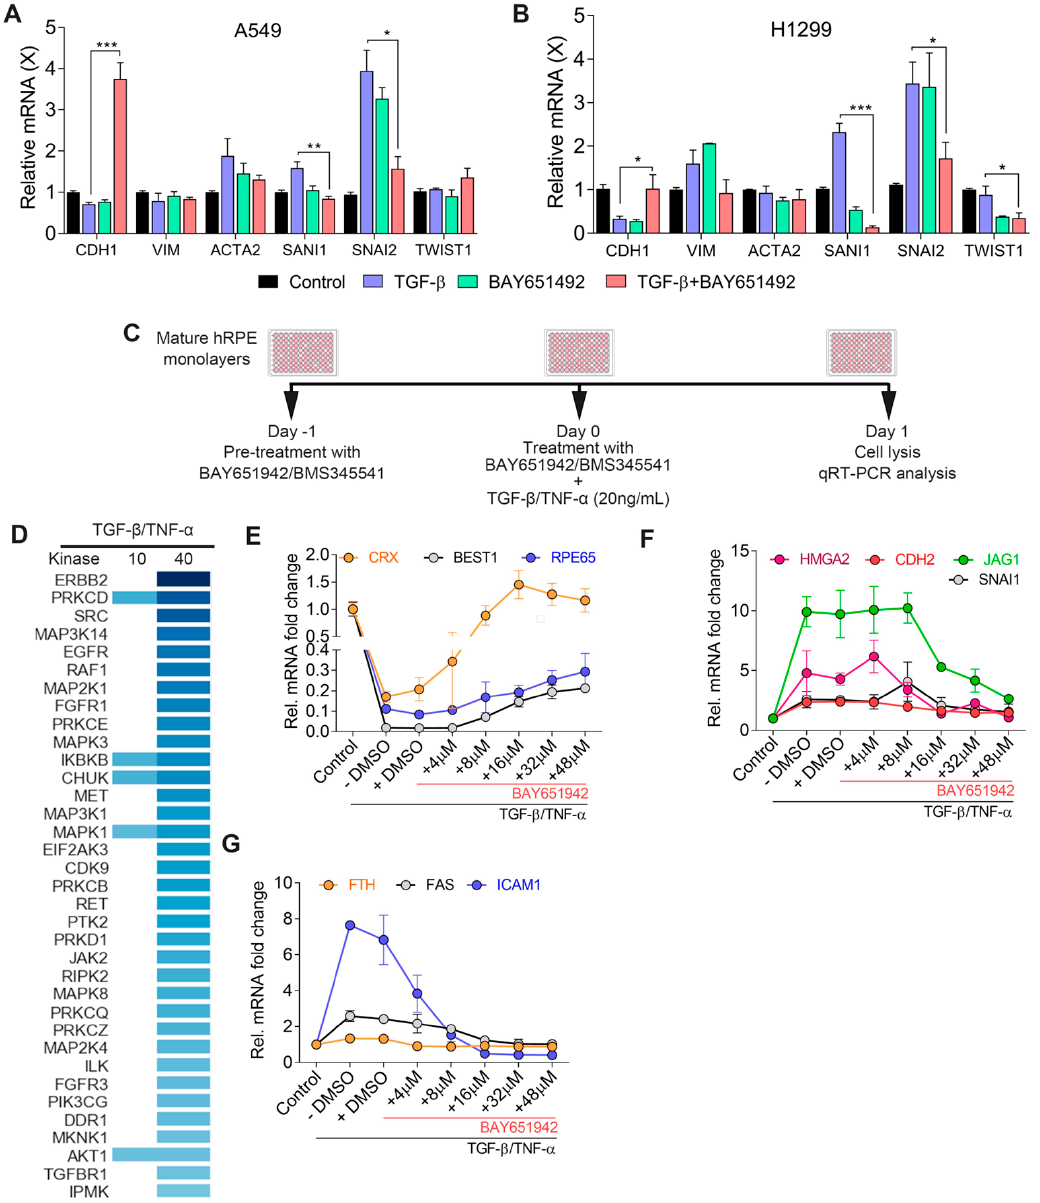
Figure 1. Identification of small molecule kinase inhibitors that modulate TGF– β /TNF– α associated RPE–EMT. qPCR validation of altered EMT-associated factors in ( A ) non-small cell lung cancer A549 and ( B ) H1299 cells. ( C ) Schematic representation of kinase inhibitors treatment and RPE–EMT induction. ( D ) Heatmap of potential small molecule kinase inhibitors identified by IPA-generated up- stream regulator analysis. qPCR analysis shows differential expression of ( E ) RPE genes, ( F ) EMT and ( G ) NF- κ B factors from TGF– β /TNF– α -induced EMT were altered by BAY651942 treatment.